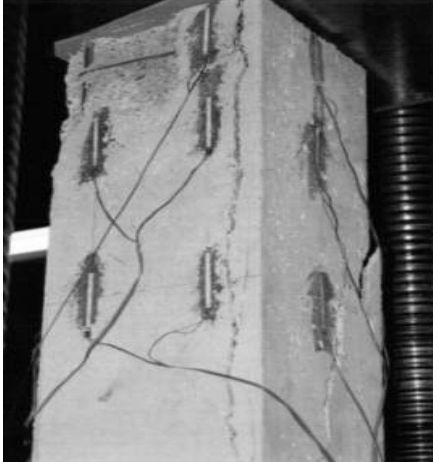
Fig 5 . Character of destruction of composite columns loaded through the steel